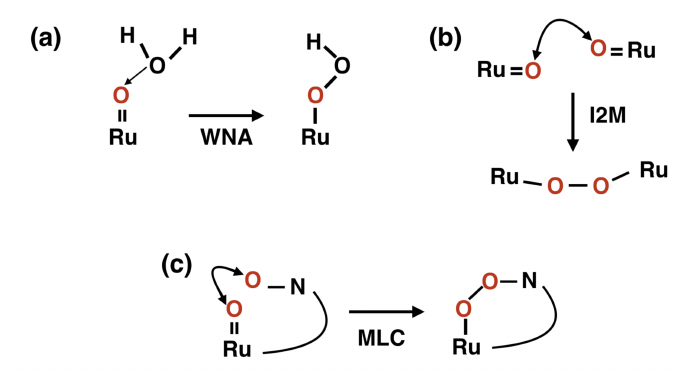
Figure 1. Proposed mechanisms for mononuclear Ru based WOCs during the O–O bond formation step, ( a ) Water nuleophilic attack (WNA), ( b ) Radical oxo coupling (I2M), and ( c ) a new metal–ligand radical coupling mechanism (MLC) (Ref. [19]) for the [Ru II (bpy) 2 (bpy–NO)] 2 + complex in this